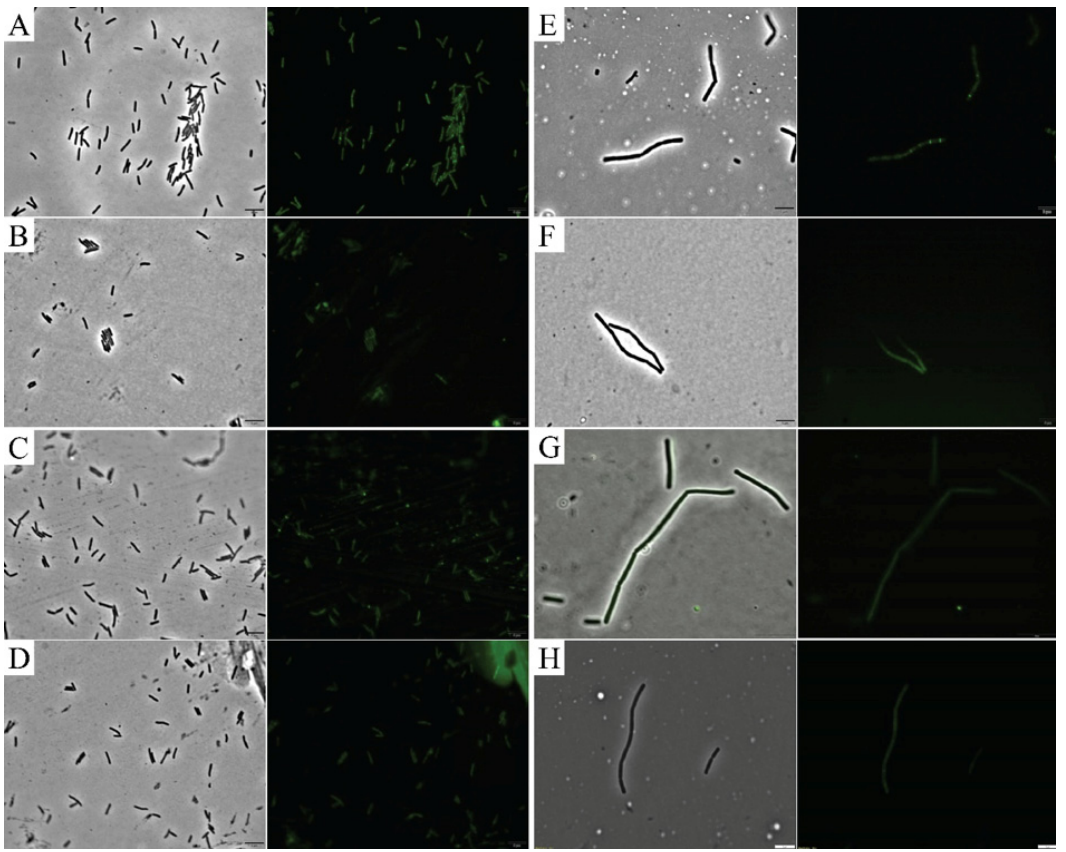
Figure 6. Effects of BC1 and T9A on bacterial cell division. Phase contrast (left) and GFP (right) images of: X. citri expressing GFP-ZapA treated for 30 min with ( A ) 1% DMSO, ( B ) BC1 (90 µ g / mL), ( C ) T9A (50 µ g / mL), ( D ) hexyl gallate (60 µ g / mL), and B. subtilis expressing FtsZ-GFP treated for 30 min with ( E ) 1% DMSO, ( F ) BC1 (50 µ g / mL), ( G ) T9A (40 µ g / mL), ( H ) hexyl gallate (60 µ g / mL). Scale bar: 5 µ